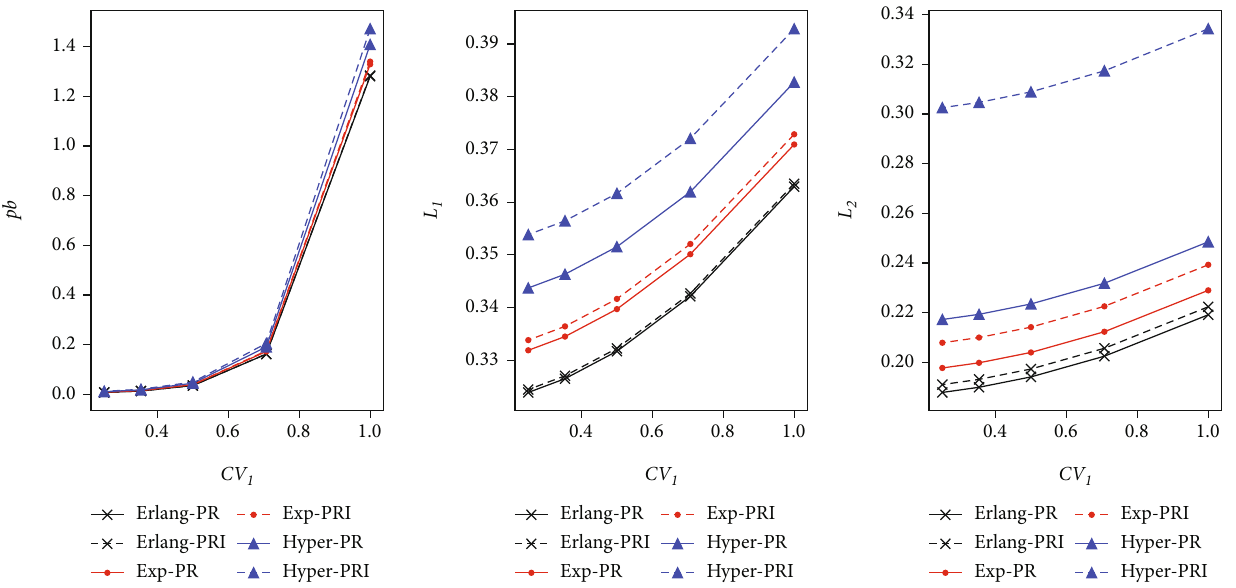
Figure 7: Performance measures for various values of CVs of S